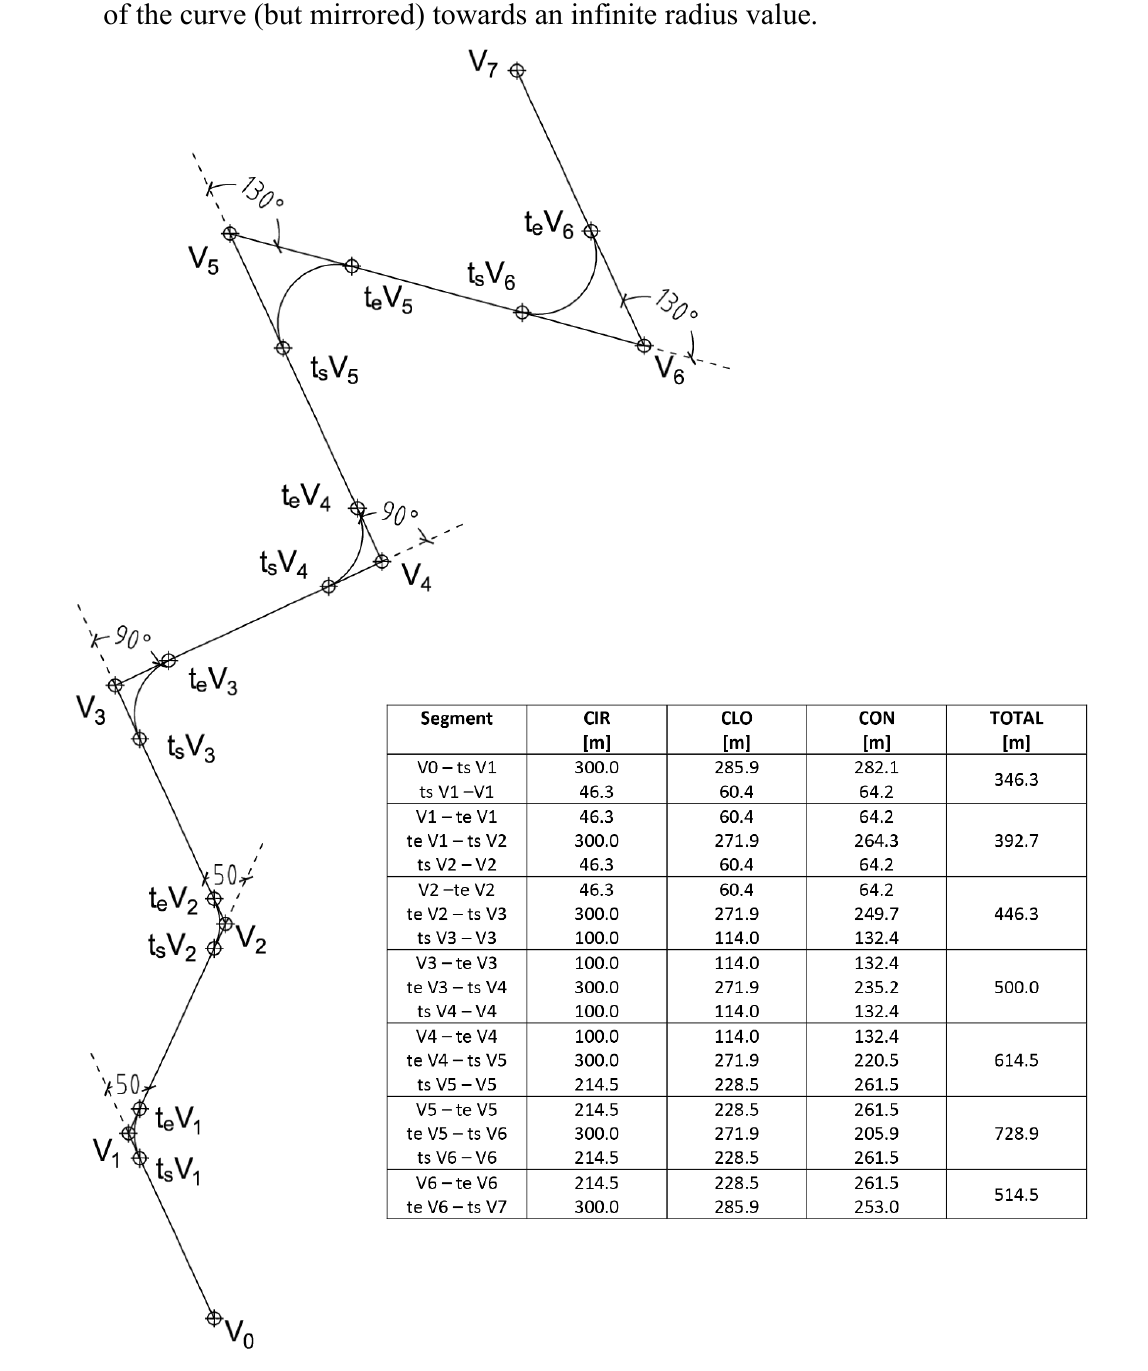
Figure 2 Road polygonal alignment driven in the trials. V are the polygonal vertices while t s (tangent start) and t e (tangent end) are the tangent points of the